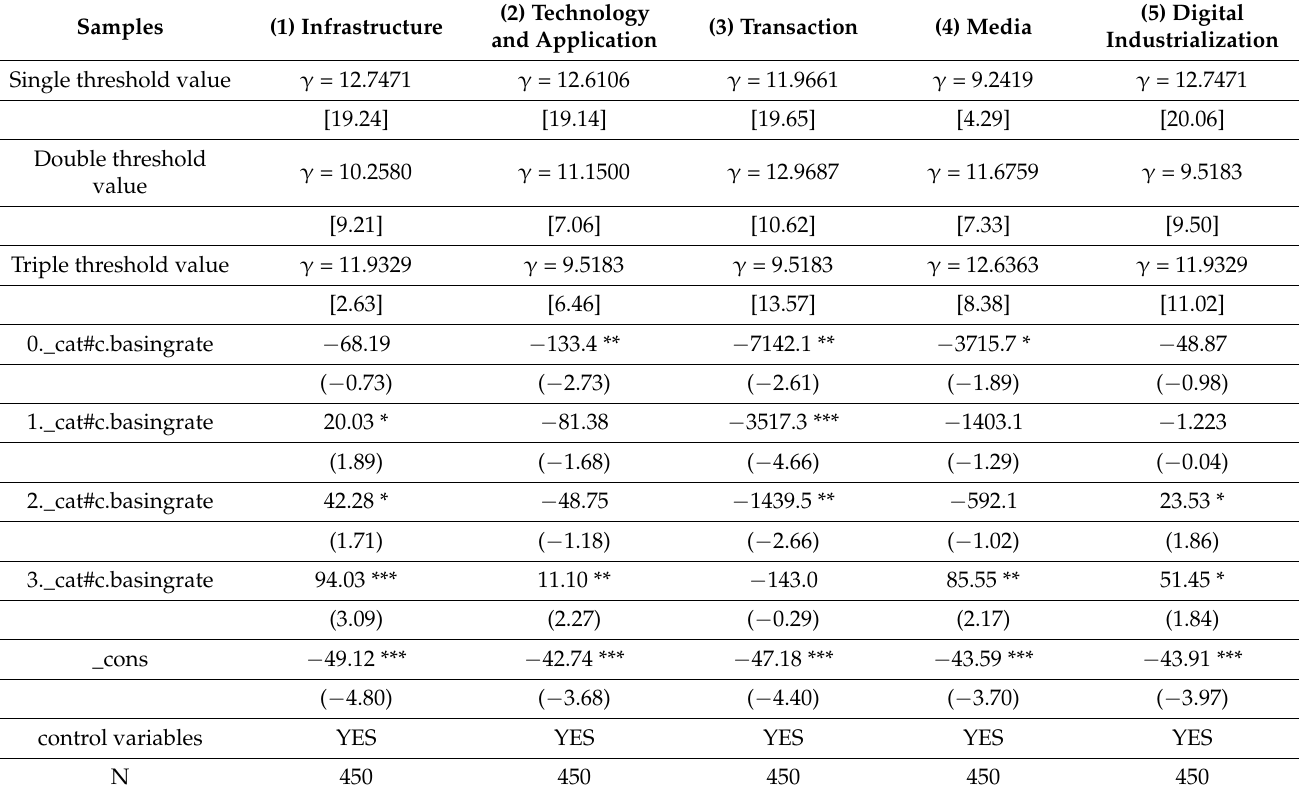
Table 5. Regression results of the threshold effect of segmented